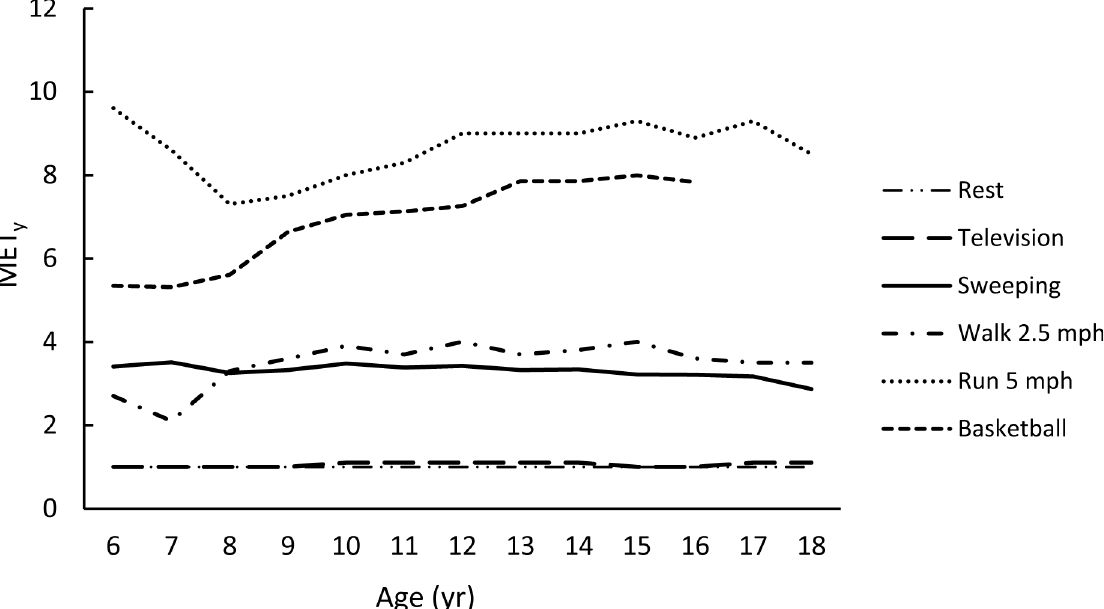
Fig 5. The relationships between age and YOUTH-MET (MET y ) for six activities representing various intensities of physical